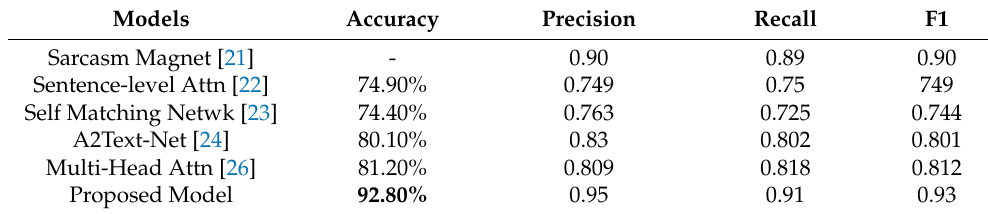
Table 3. Performance comparison of the Twitter